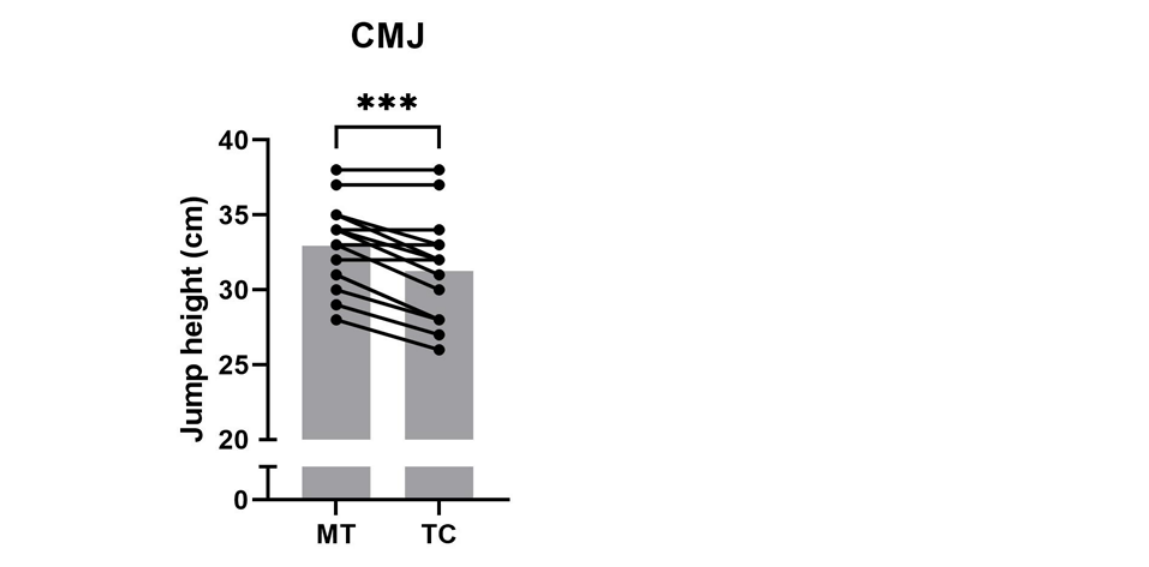
Figure 2. The counter movement jump (CMJ) performance measured after the weeks of moderate training (MT) and intensive training camp (TC). Gray bars represent means, lines connect values from individual participants from MT to TC. Paired t test, n = 15, *** p < 0.001. Peripheral white blood cell and peripheral granulocyte numbers increased significantly from MT to TC (both p < 0.01, d = 1.40 and 1.93 (large), respectively) with no significant change in lymphocyte and monocyte numbers ( p > 0.05). Significant decreases in percentages of lymphocytes ( p < 0.05, d = 1.17, large) and monocytes ( p < 0.01, d = 1.05, large), and a significant increase in the percentage of granulocytes ( p < 0.05, d = 0.86, large) was observed. No significant differences were observed from MT to TC for red blood cells, hemoglobin, or hematocrit (all, p > 0.05). Creatinine significantly increased from MT to TC ( p < 0.01, d = 1.29, large). No significant difference in urea was observed from MT to TC ( p > 0.05) (Table 6). Table 6. The change in blood markers from after the week of moderate training (MT) to after intense training camp (TC) (values are mean ± SD; n = 15). MT TC Mean % Change Effect Size (d) Rating